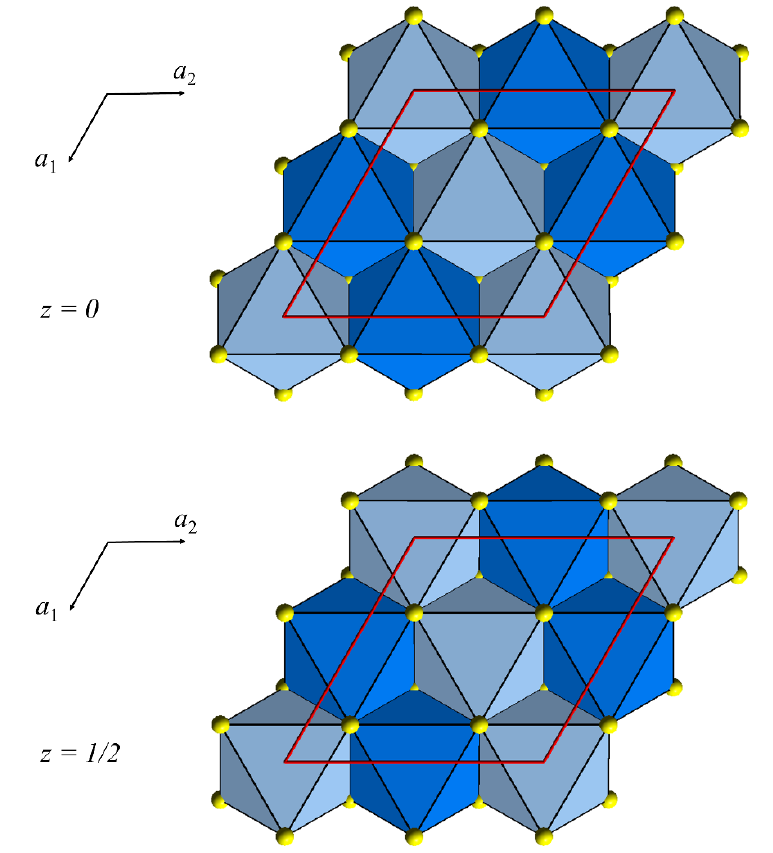
Figure 4. Octahedral layers in eliopoulosite projected down [001]. Layer at z = 0 (top of picture) repeats at z = 1 / 3 and z = 2 / 3; layer at z = 1 / 2 (bottom of picture) repeats at z = 1 / 6 and z = 5 / 6. Blue and pale blue colors represent full and partial occupancy. Sulfur atoms are depicted in yellow. The unit cell and the orientation of the structure are indicated.